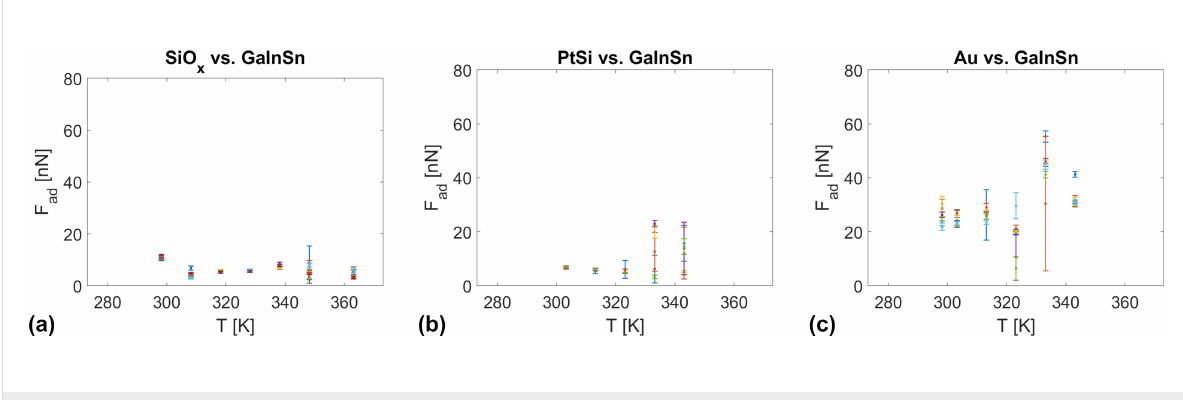
Figure 4: F ad ( T ) plots for different pulling velocity values d Z /d t = 0.25–25 mm/s for (a) a SiO x tip, (b) a PtSi tip, and (c) a gold